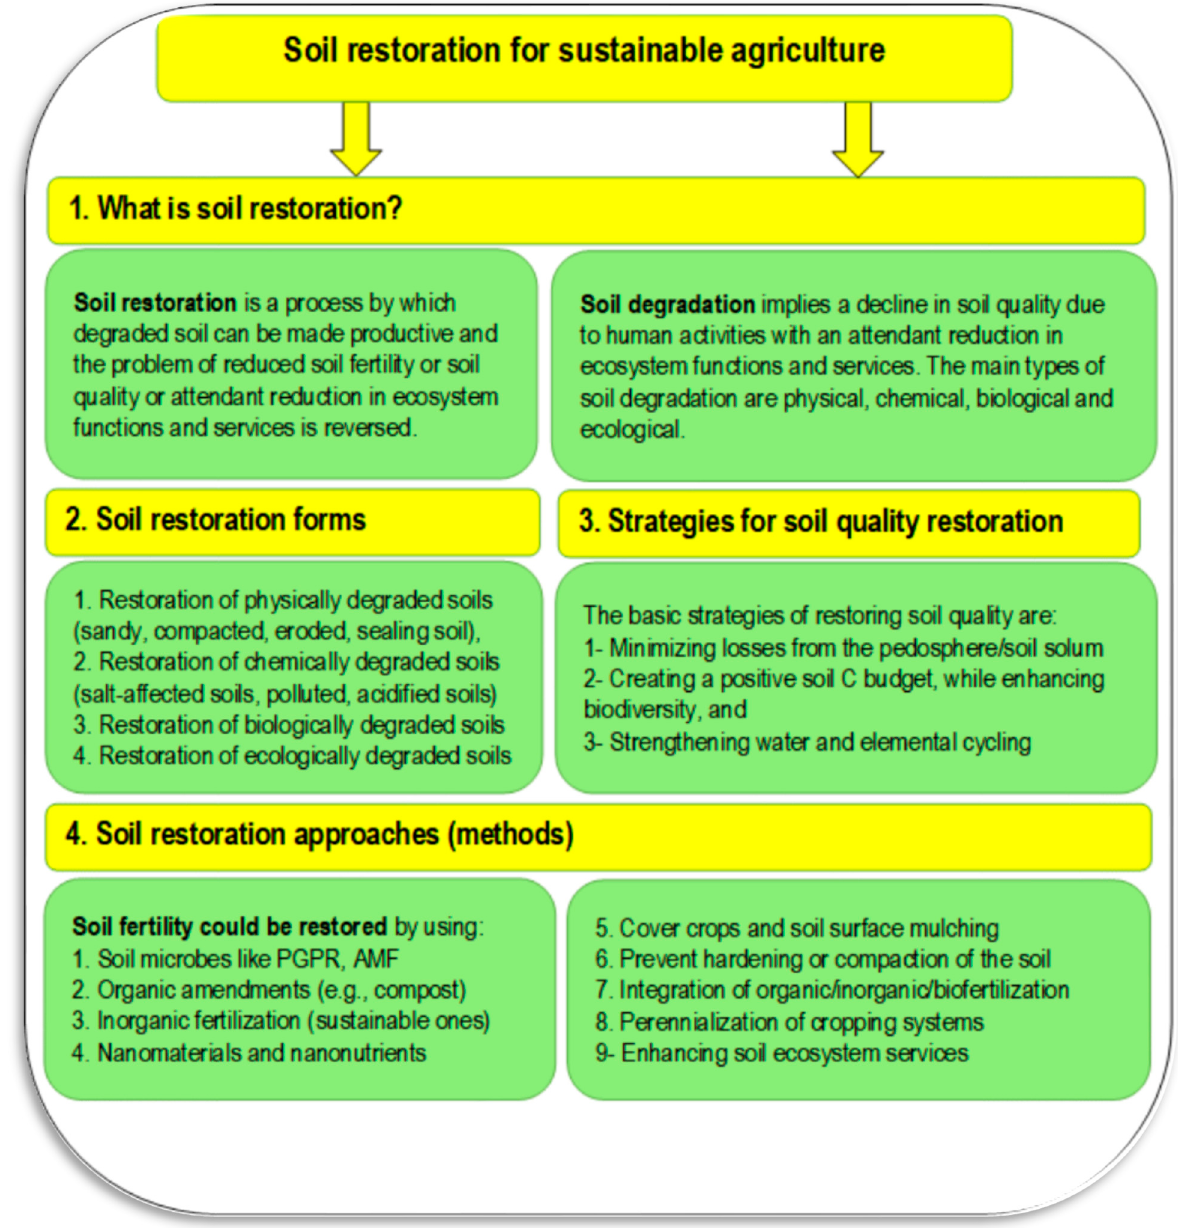
Figure 2. Soil restoration for sustainable agriculture including the forms, the approaches, and strate- gies (Sources: [31,38,39]). Abbreviations: Plant growth promoting rhizobacteria (PGPR), arbuscular mycorrhizal fungi